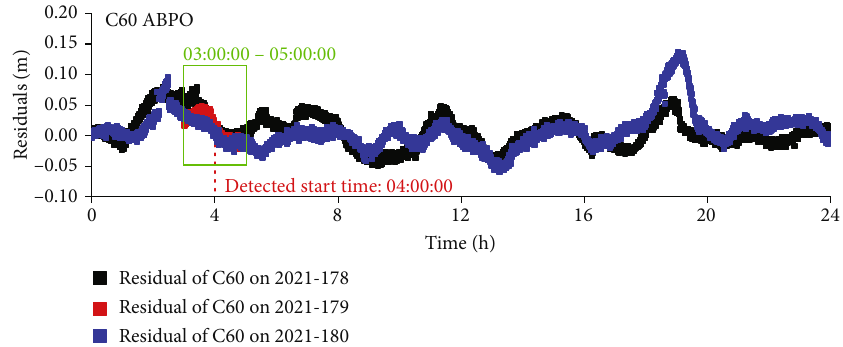
Figure 9: Comparison of the residuals one hour before and after the detected maneuver start time (green box) with the residuals when no maneuver occurred.